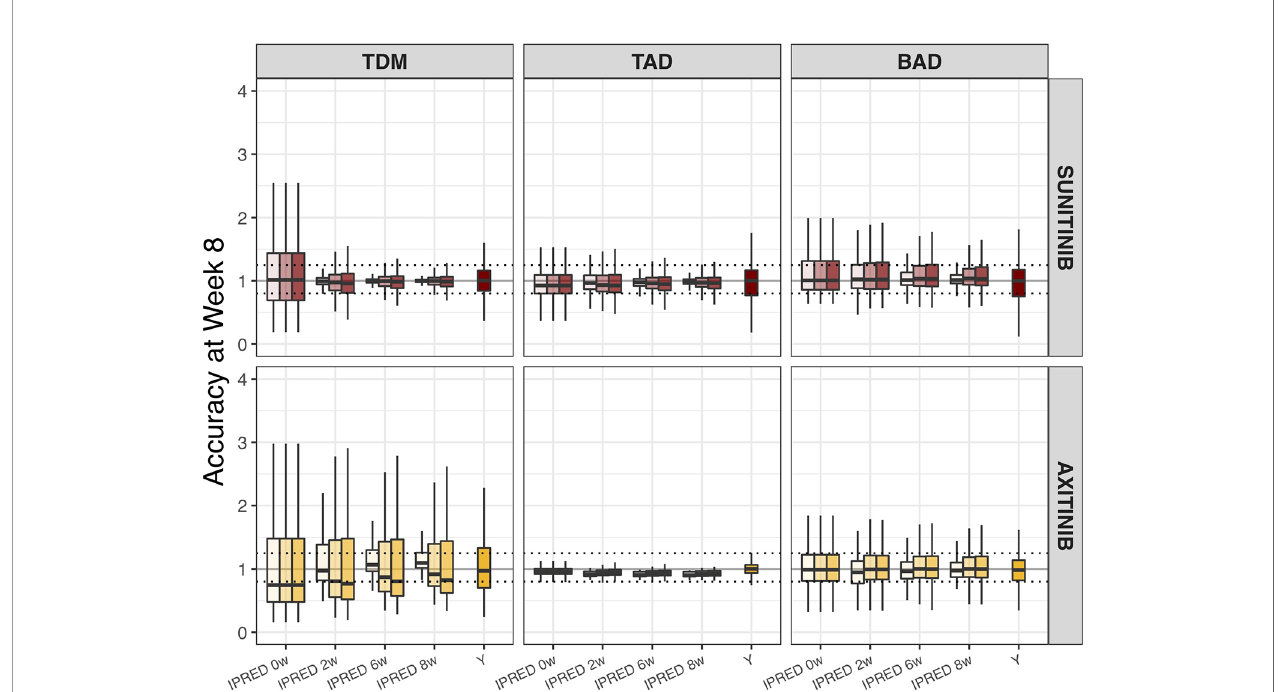
FIGURE 3 | Accuracy of biomarker forecasts (IPRED) versus clinical sample-based methods (Y). Accuracy in the simulated population (n = 1,000) as illustrated by the distribution of model-based biomarker forecasts (BIOMARKER IPREDest ) or directly measured sample values (Y) under continuous bidaily dosing of axitinib at 5 mg or daily dosing of sunitinib at 37.5 mg. Accuracy = [Predicted (BIOMARKER IPREDest ) or Measured (Y) biomarker change/Actual biomarker change (BIOMARKER IPREDtrue )]. Each plot represents forecasts accuracies at week 8 under different monitoring durations (0, 2, 4, 6, or 8 weeks; IPRED on x-axis) and sampling frequencies (daily [light], weekly [medium], or biweekly [dark]; color shades). For directly measured clinical samples (Y on x-axis) each plot represents the accuracy to capture the true biomarker change at week 8, using one measurement at baseline and one at week 8. Solid black line means 100% accuracy and represents the state at which predicted biomarker change = actual biomarker change. Dashed horizontal lines represent the range wherein the predicted biomarker change falls within the 80 – 125% range of the true biomarker change. The ends of each box represent the population 25th and 75th percentiles and whiskers the 2.5th and 97.5th percentiles, respectively. Median is represented by the line that cuts through each box in the plot. BAD, biomarker-based dosing; TAD, toxicity- adjusted dosing (ANC for sunitinib; dBP for axitinib); TDM, therapeutic drug